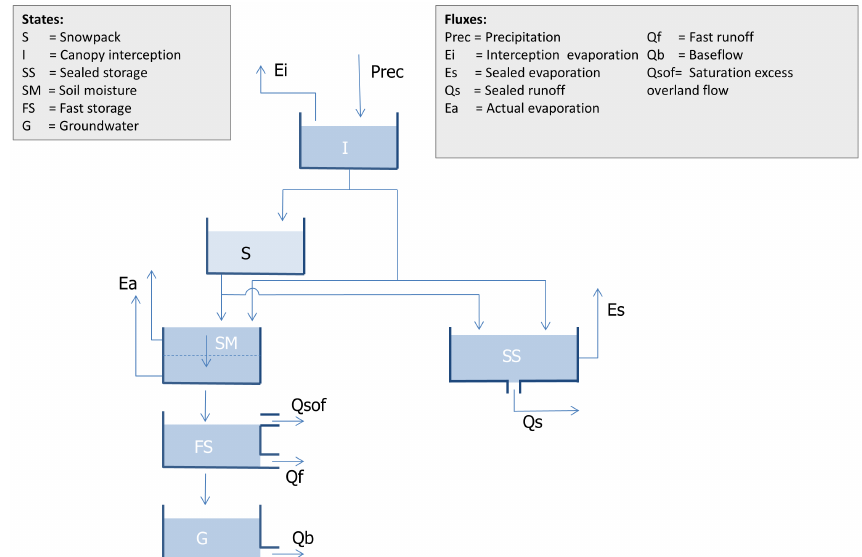
Figure 2. The original mHM model structure. The effective precipitation is determined by an interception (I) and a snow routine (S). Afterwards, the effective precipitation enters a soil moisture reservoir (SM) or is directly routed to a fast reservoir that accounts for sealed areas (SS). The water in the soil moisture reservoir either transpires or percolates further down to a fast runoff reservoir (FS), i.e. shallow subsurface flow. Eventually, the baseflow component of the runoff is obtained from a slow groundwater reservoir (G).